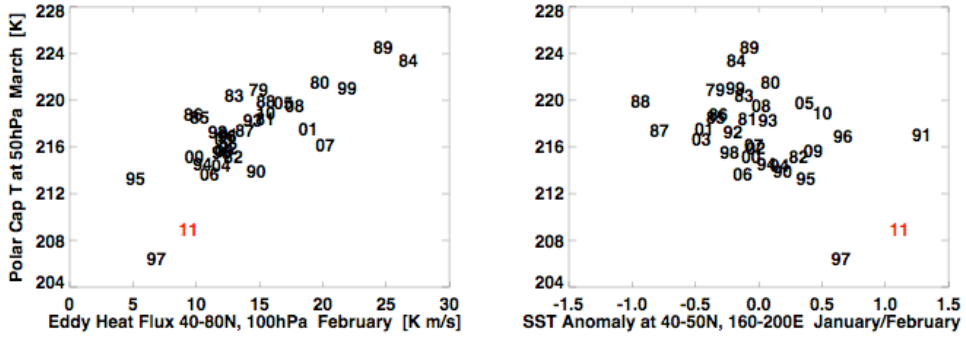
Fig. 2. (left) Meridional eddy heat flux at 40–80 ◦ N, 100hPa [Kms − 1 ] in February as a function of Arctic polar cap temperature at 50hPa [K] in March; (right) January/February SST anomaly at 40–50 ◦ N, 160–200 ◦ E [K] as a function of Arctic polar cap temperature at 50hPa [K] in March. Eddy heat flux, SST anomaly and temperature values are denoted by year number (e.g., “11” denotes